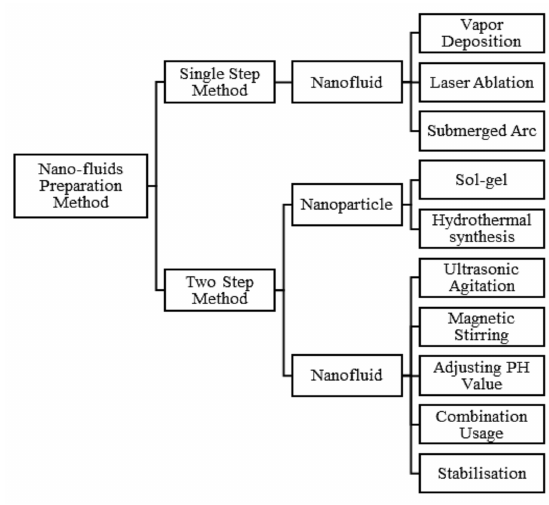
Figure 1. Classification of preparation methods.